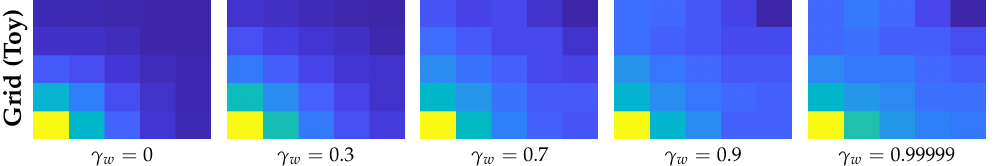
Figure 20. Performance of the our algorithms on varying of γ w on the “toy” gridworld (Figure 14). The higher γ w , the more the agent explores, allowing to discover the reward faster.